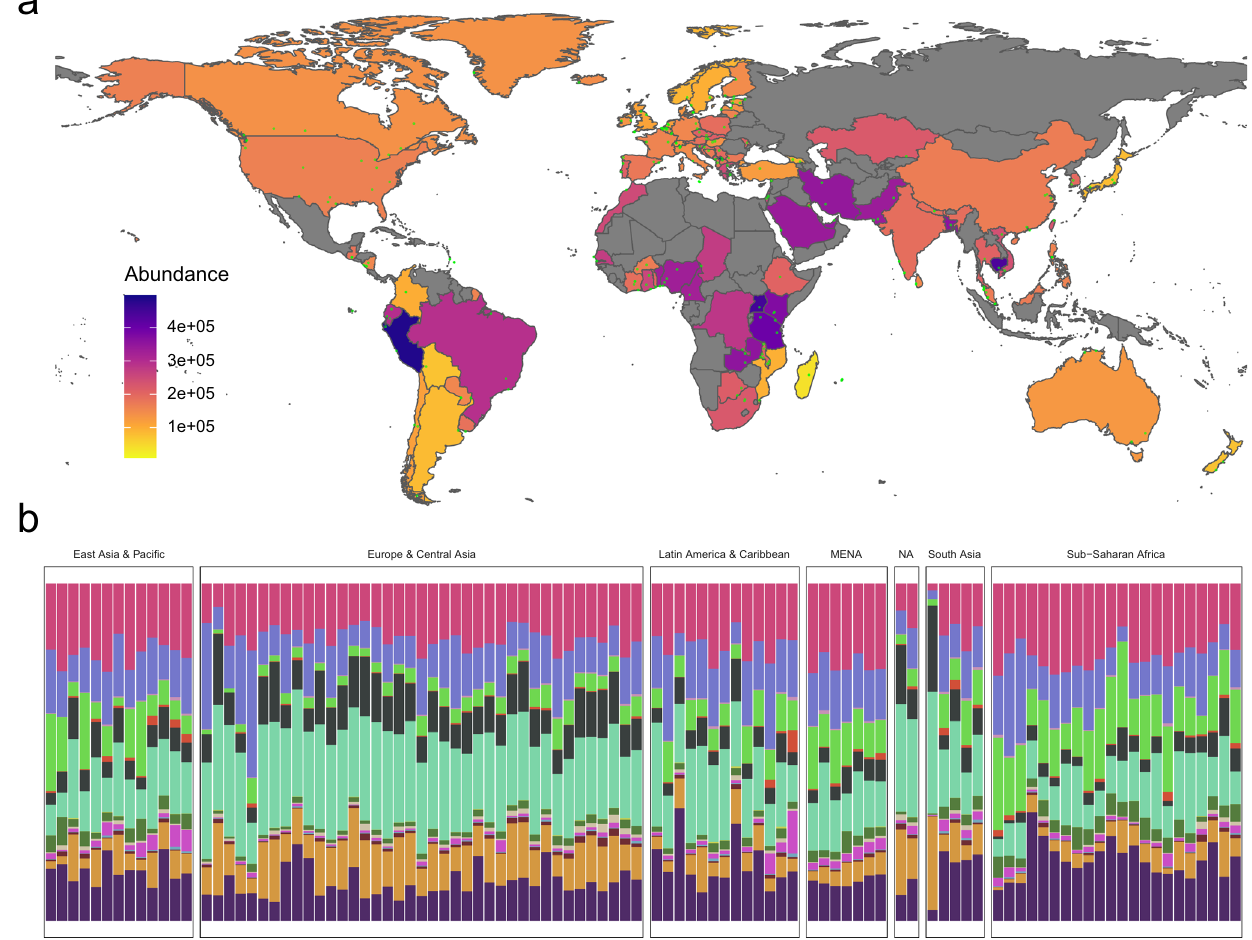
Fig. 1 | The global resistome based on sewage-based monitoring. a Choropleth of the world coloured by the country-wise average total AMR load (see methods). Small green dots show unique sampling sites contributing to the average. Some areas are disputed, and we realize that exact border placement is dif fi cult due to